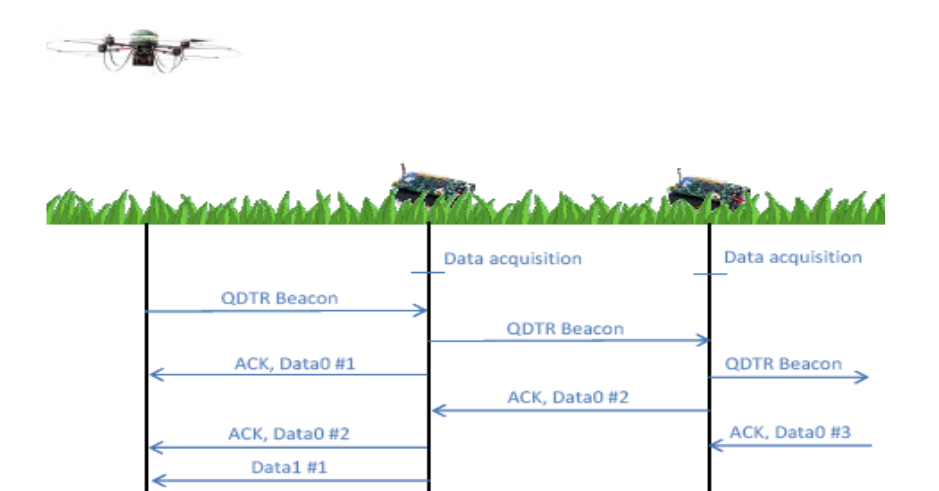
Figure 4. Communications